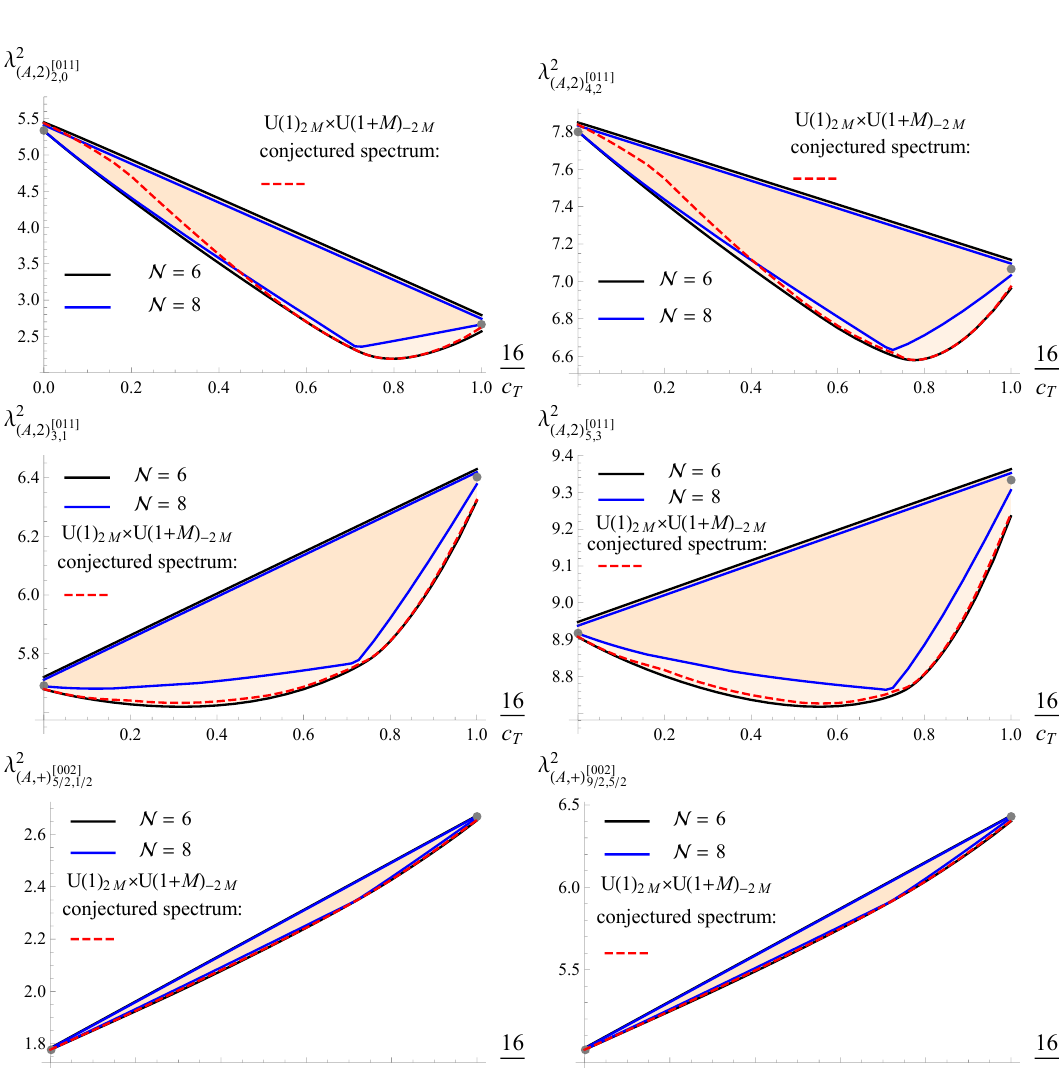
Figure 2 . Upper and lower bounds on various semishort OPE coefficients squared in terms of c T , where the orange shaded regions are allowed, and the plots ranges from the GFFT limit c T → ∞ to the free theory c T = 16 . The black lines denote the N = 6 upper/lower bounds computed in this work with Λ = 39 , the blue lines denote the N = 8 upper/lower bounds computed in [10] with Λ = 43 . The red dashed lines denotes the spectrum read off from the functional saturating the lower bound in figure 1, which we identify with the U(1) 2 M × U(1 + M ) − 2 M theory. The gray dots denote the GFFT and free theory values from table